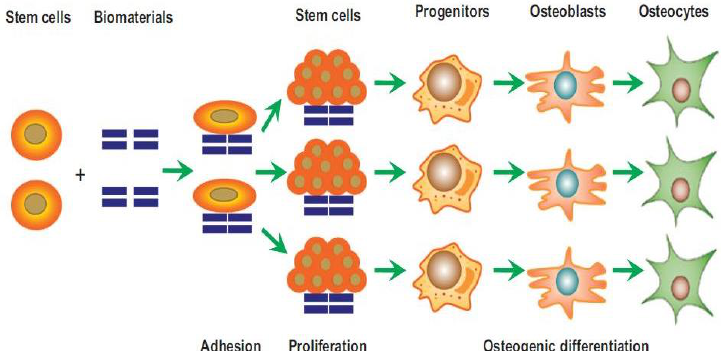
Figure 3: Adhesion, proliferation, and differentiation of bone biomaterials in contact with stem cells [17]